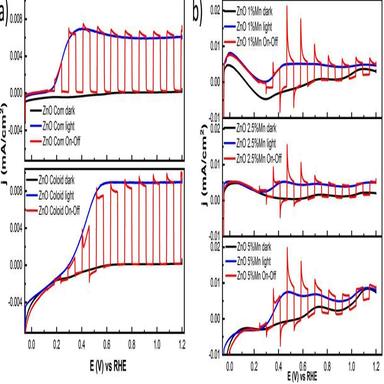
a) Linear sweep voltammograms recorded for the prepared ZnO and commercial ZnO electrodes under darkness and b) Linear sweep voltammograms recorded for the prepared p-MnO/n-ZnO with (Mn = 0.5%, 1.1% and 2.25% electrodes under darkness, UV–vis light and transient curves. v = 5 mVs−1 with I = 34 mWcm-2.